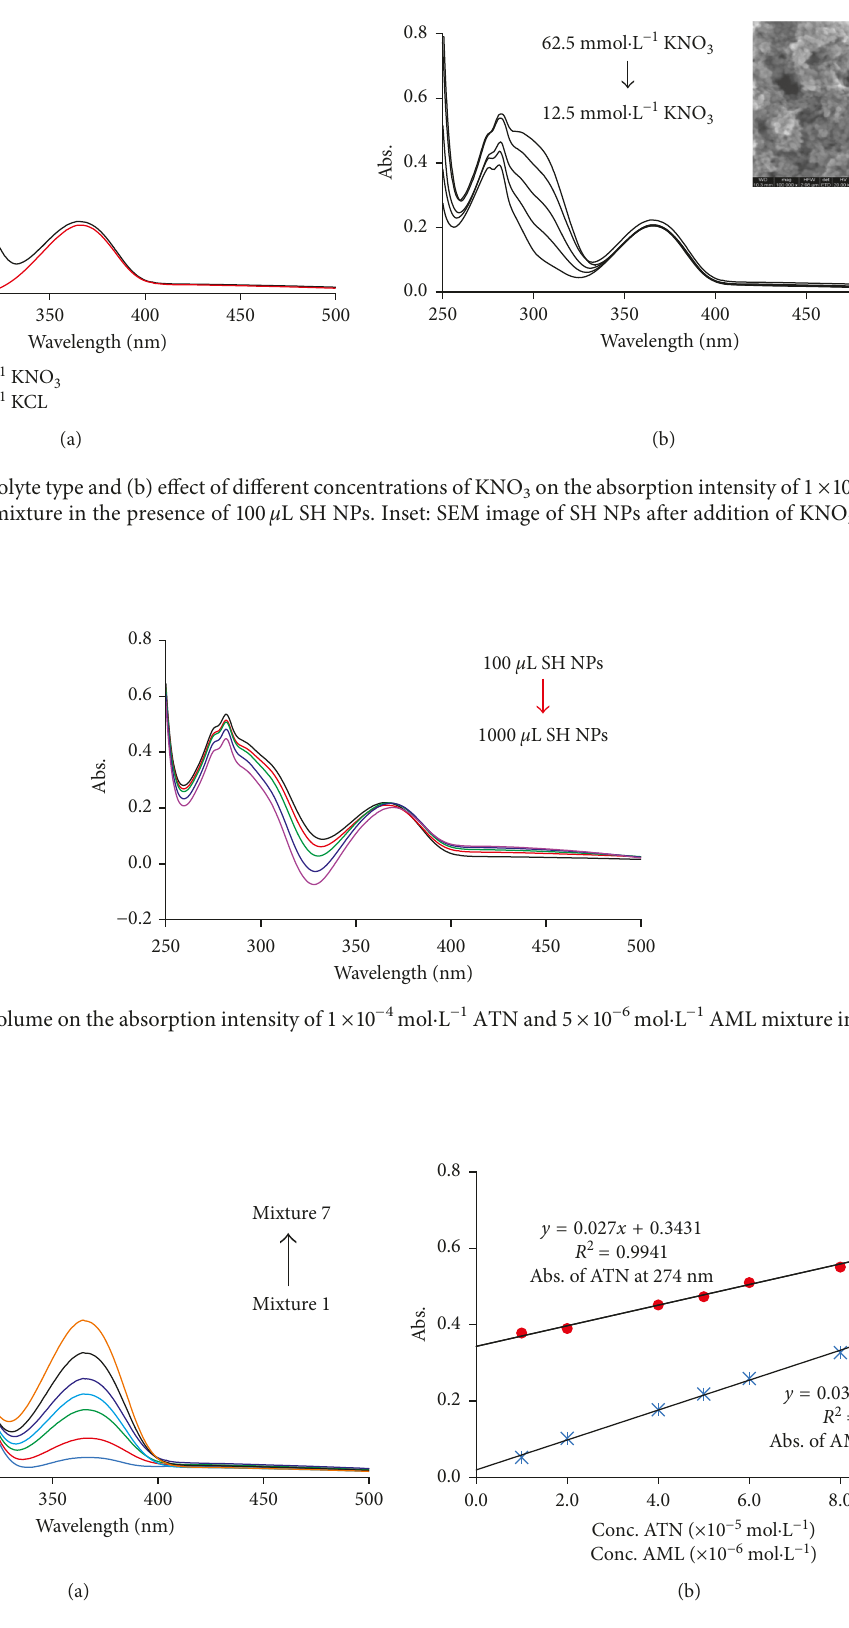
6 mol 1 AML, respectively. (b) Linear relationship curves of ATN (measured at 274nm) 10 L × · 1 KNO L − − 3 · −